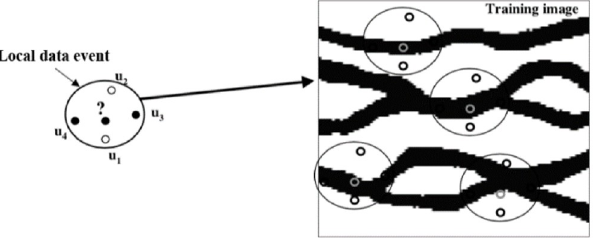
Fig 2. Search template and data events (black represents a channel region, white represents background)